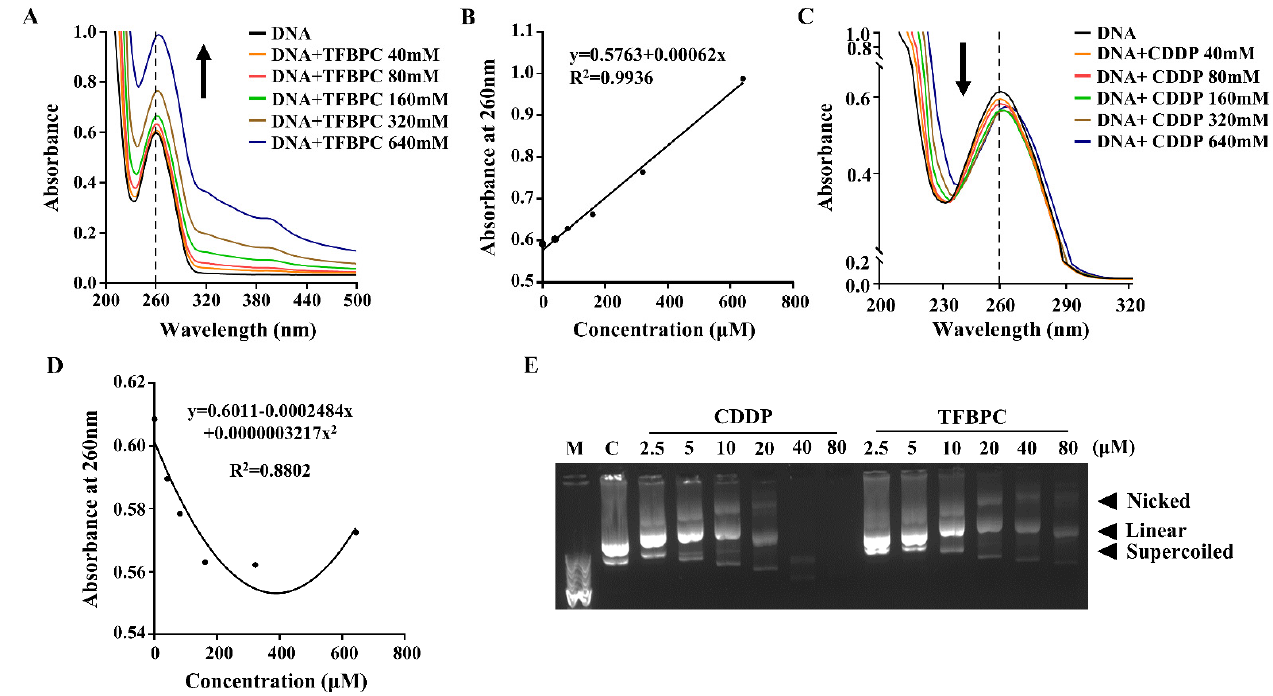
Figure 1. TFBPC chelated into calf thymus DNA and supercoiled plasmid leading to structural instability. UV-visible absorption spectra of calf thymus DNA with different TFBPC ( A ) or CDDP ( C ) concentrations (40–640 µ M) after 6 h incubation at 37 ◦ C. The vertical black line demonstrated the maximal absorbance for pure DNA at 260 nm in the absorbance–wavelength plot. The recorded absorbance at 260 nm for a dilution series of TFBPC ( B ) and CDDP ( D ) was plotted, and the equation of linear regression line or the second-order polynomial (quadratic) trendline in TFBPC-DNA or CDDP-DNA interaction groups were shown. The gel mobility shift assay for constant plasmid (25 ng/ µ L) mixed with CDDP or TFBPC for 24 h at 37 ◦ C was applied and three bands (supercoiled, linear, nicked) were identified on 1% agarose gel ( E ). M and C indicate 1 Kb DNA marker and negative control (plasmid alone) loaded in DNA